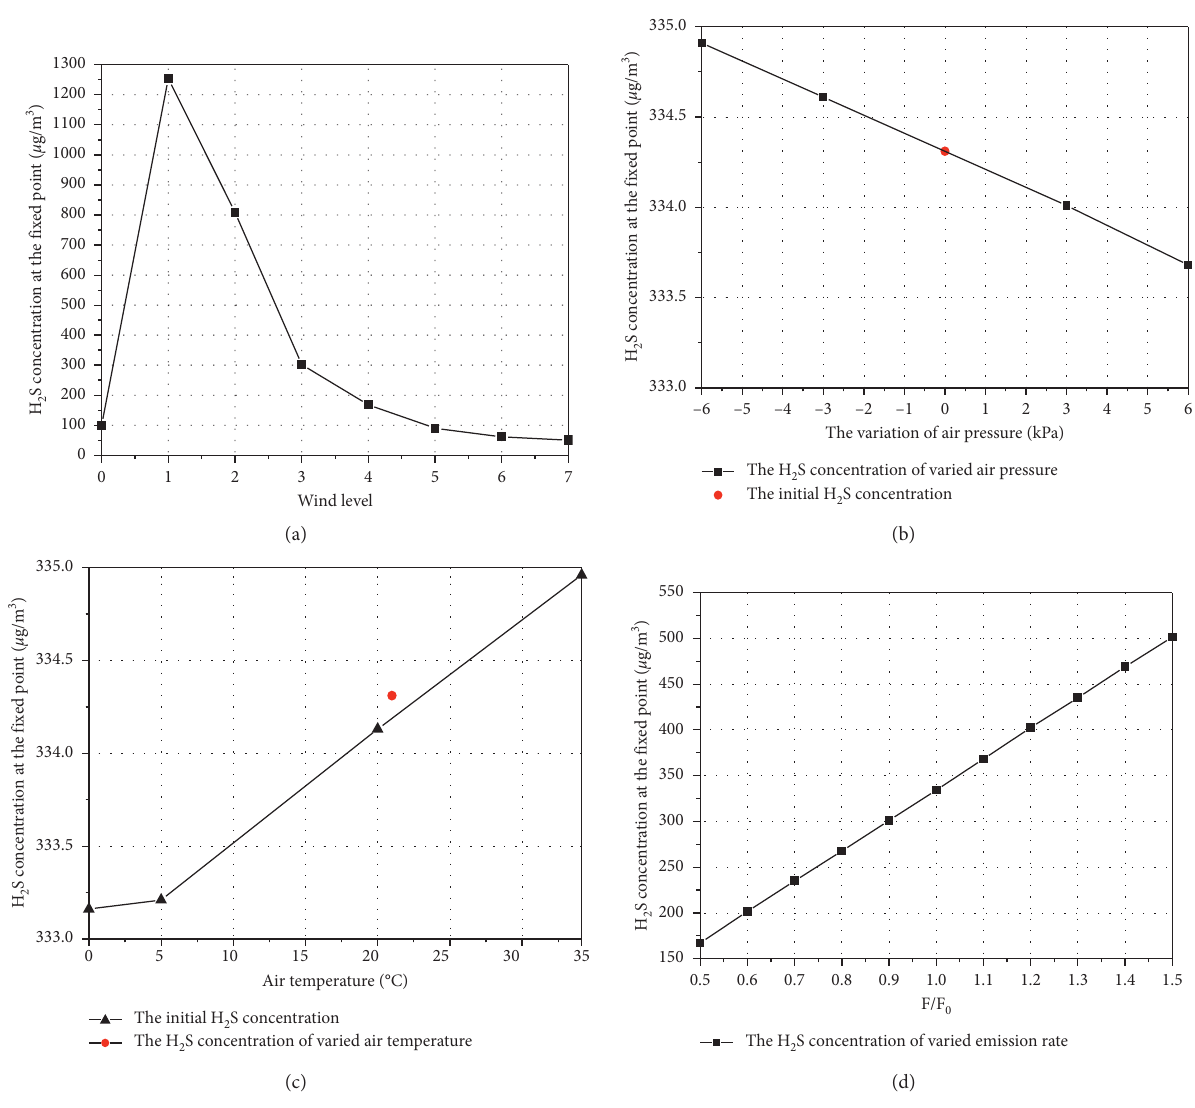
Figure 5: The varied H 2 S concentration with different factors. (a) Wind level. (b) Air pressure. (c) Air temperature. (d) Emission rate. Table 1: A detailed complain inventory of no. 11 in August, September, and